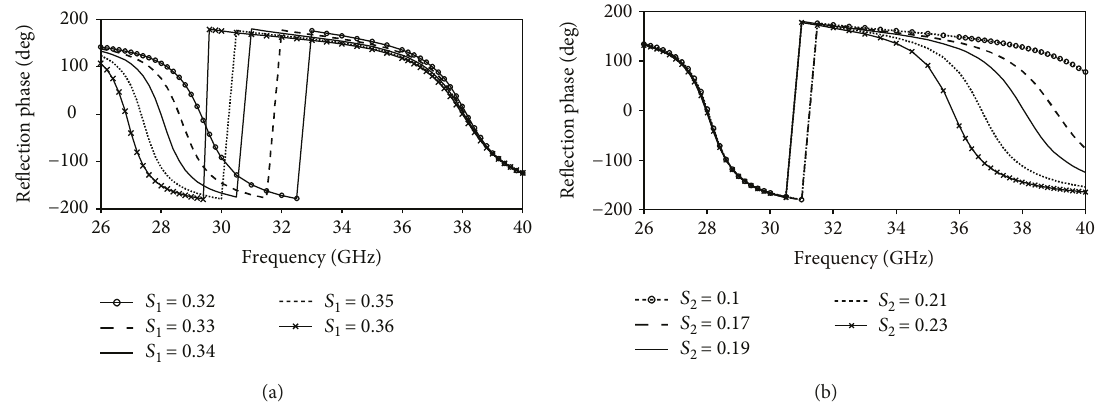
= 1 95mm , S = variable and L 1 1